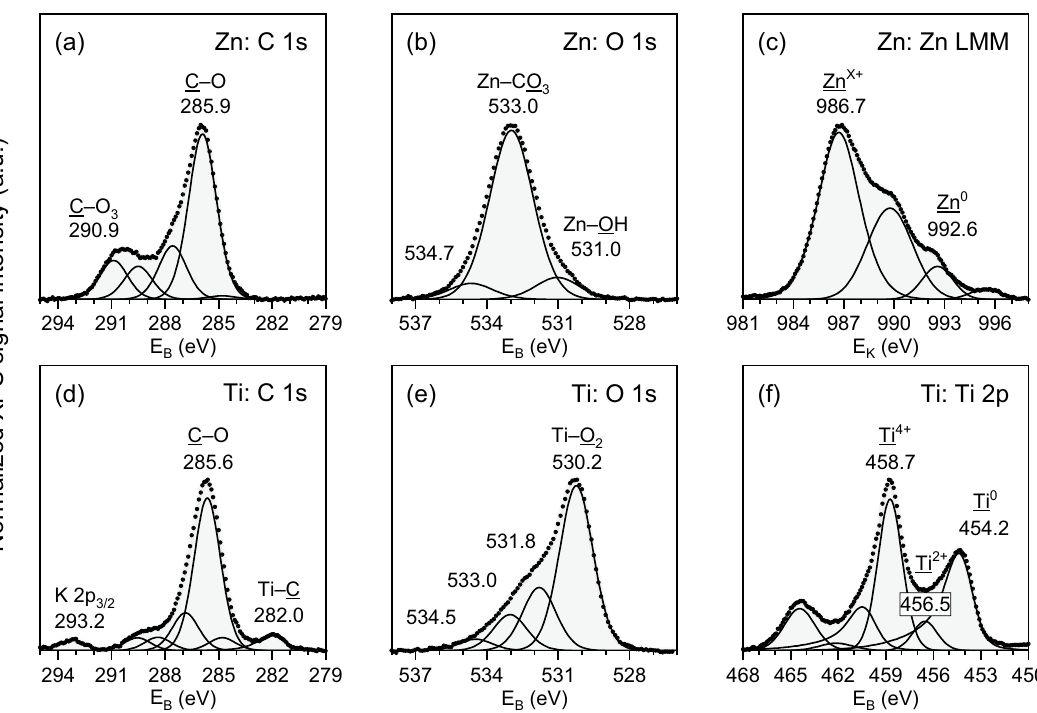
Figure 3. The XPS/XAES core level spectra of Zn sample: ( a ) C 1s, ( b ) O 1s, ( c ) Zn LMM, and Ti sample: ( d ) C 1s, ( e ) O 1s, (f) Ti